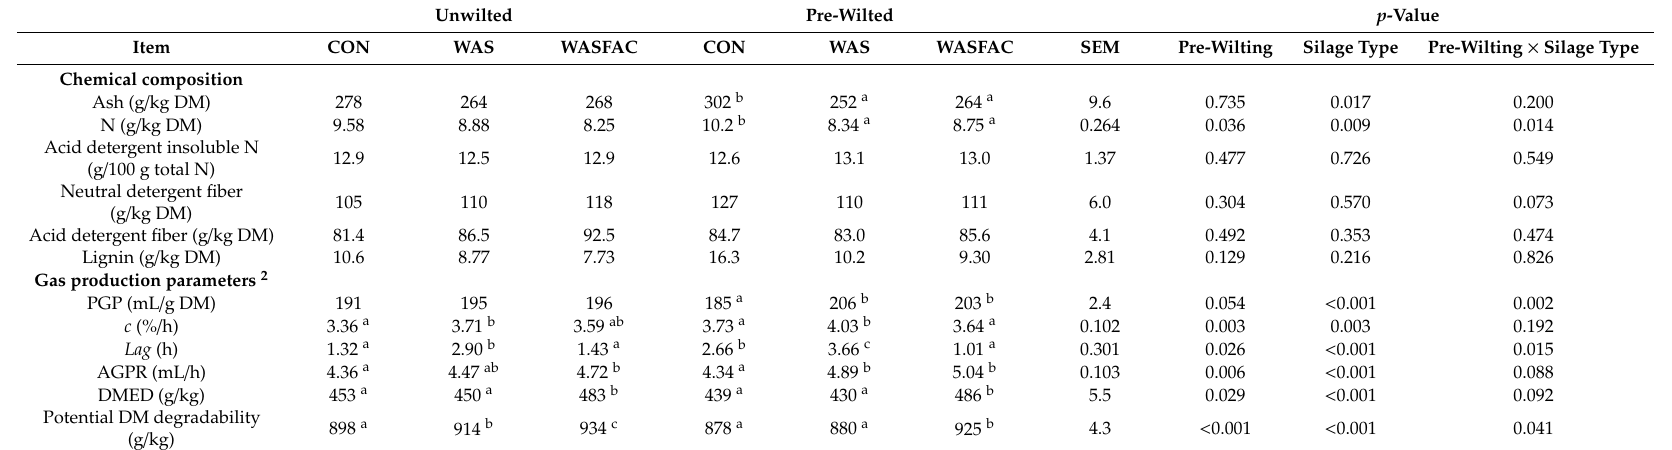
Table 5. Chemical composition and gas production parameters of Saccharina latissima silages 1 . Unwilted Pre-Wilted p -Value Item CON WAS WASFAC CON WAS WASFAC SEM Pre-Wilting Silage Type Pre-Wilting × Silage